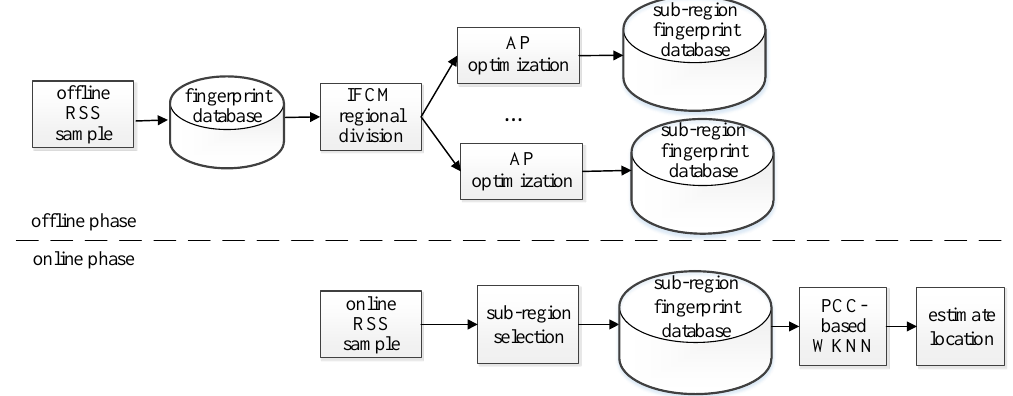
Figure 1. Fingerprint localization method.